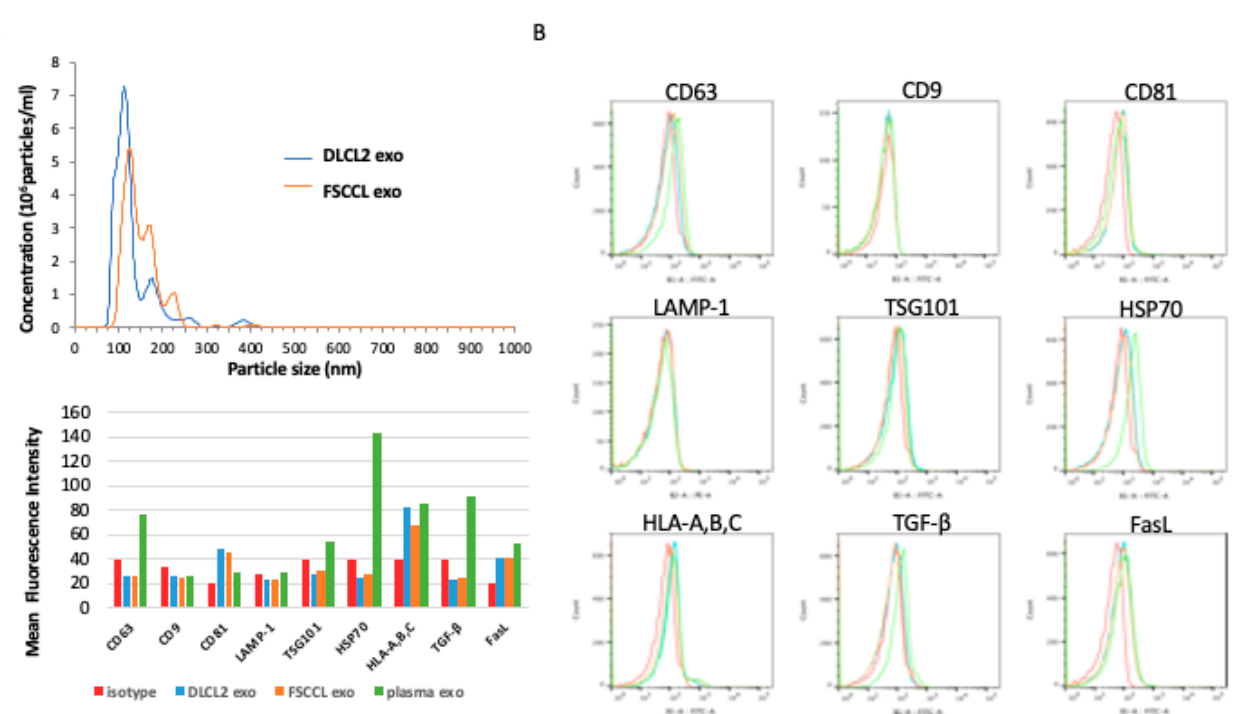
Figure 1. Extracellular vesicles (EVs) derived from WSU-DLCL2 and WSU-FSCCL lymphoma cell lines are exosomes. ( A ) Sizing analysis of lymphoma EVs was performed with the NanoSight NS300. Mean size for exosomes was 137 nm (+/ − 56 nm) for DLCL2 and 156 nm (+/ − 63 nm) for FSCCL. ( B ) For analysis of expression of surface molecules, 200 µg of exosomes was incubated with 10 µL of 4-µm-diameter aldehyde/sulfate latex beads and stained with antibodies for EVs: CD63, CD9, CD81, lysosomal membrane glycoproteins CD107a (LAMP-1), TSG101, HSP70, HLA-A,B,C, TGF- β , and FasL. Only the population containing single beads was gated and analyzed. Red = isotype, green = plasma exosomes, blue = DLCL2 exosomes, and orange = FSCCL exosomes. ( C ) Mean fluorescence intensity (MFI) of exosome staining was compared with exosomes stained with an isotype control and exosomes from plasma. A “bead-only” control, as well as isotype-matched antibody controls were also prepared. Samples were washed twice, fixed with 1% paraformaldehyde, and analyzed using a MACSQuant Analyzer and FlowJo software.